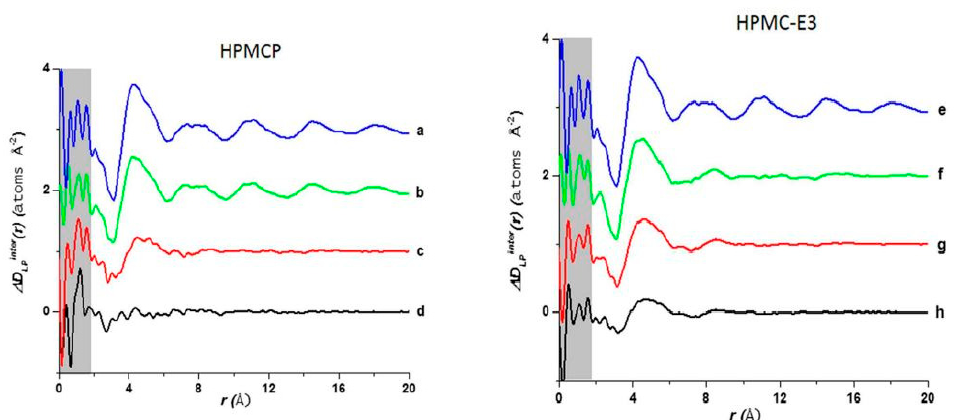
Figure 13. Comparison of the intermolecular differential pair distribution functions of drug-polymer mixtures: ( a , e ) pure lapatinib (LP) (spray dried (SD)); ( b ) 3:1 LP:HPMCP; ( c ) 1:1 LP:HPMCP; ( d ) 1:3 LP:HPMCP; ( f ) 3:1 LP:HPMC-E3; ( g ) 1:1 LP:HPMC-E3; ( h ) 1:3 LP:HPMC-E3. The gray area represents the low-r density region where systematic errors are more prone. The figure was taken from de Araujo, G.L., C.J. Benmore, and S.R. Byrn, Local Structure of Ion Pair Interaction in Lapatinib Amorphous Dispersions characterized by Synchrotron X-Ray diffraction and Pair Distribution Function Analysis. Scientific Reports, 2017. 7: p. 46367. Copyright (2017), with permission from Springer Nature [113].